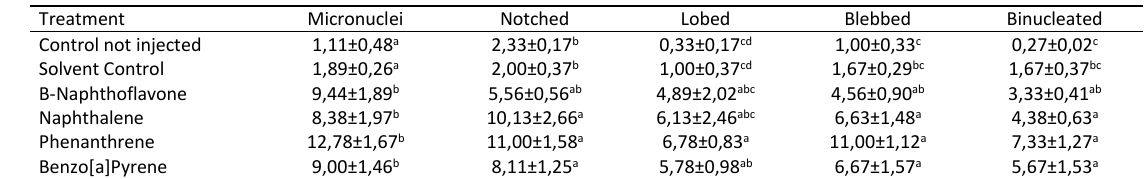
Table 3: Frequency of micronuclei and other nuclear abnormalities in peripheral blood of juvenile A. metae exposed to different concentrations of PAH after 72 h Treatment